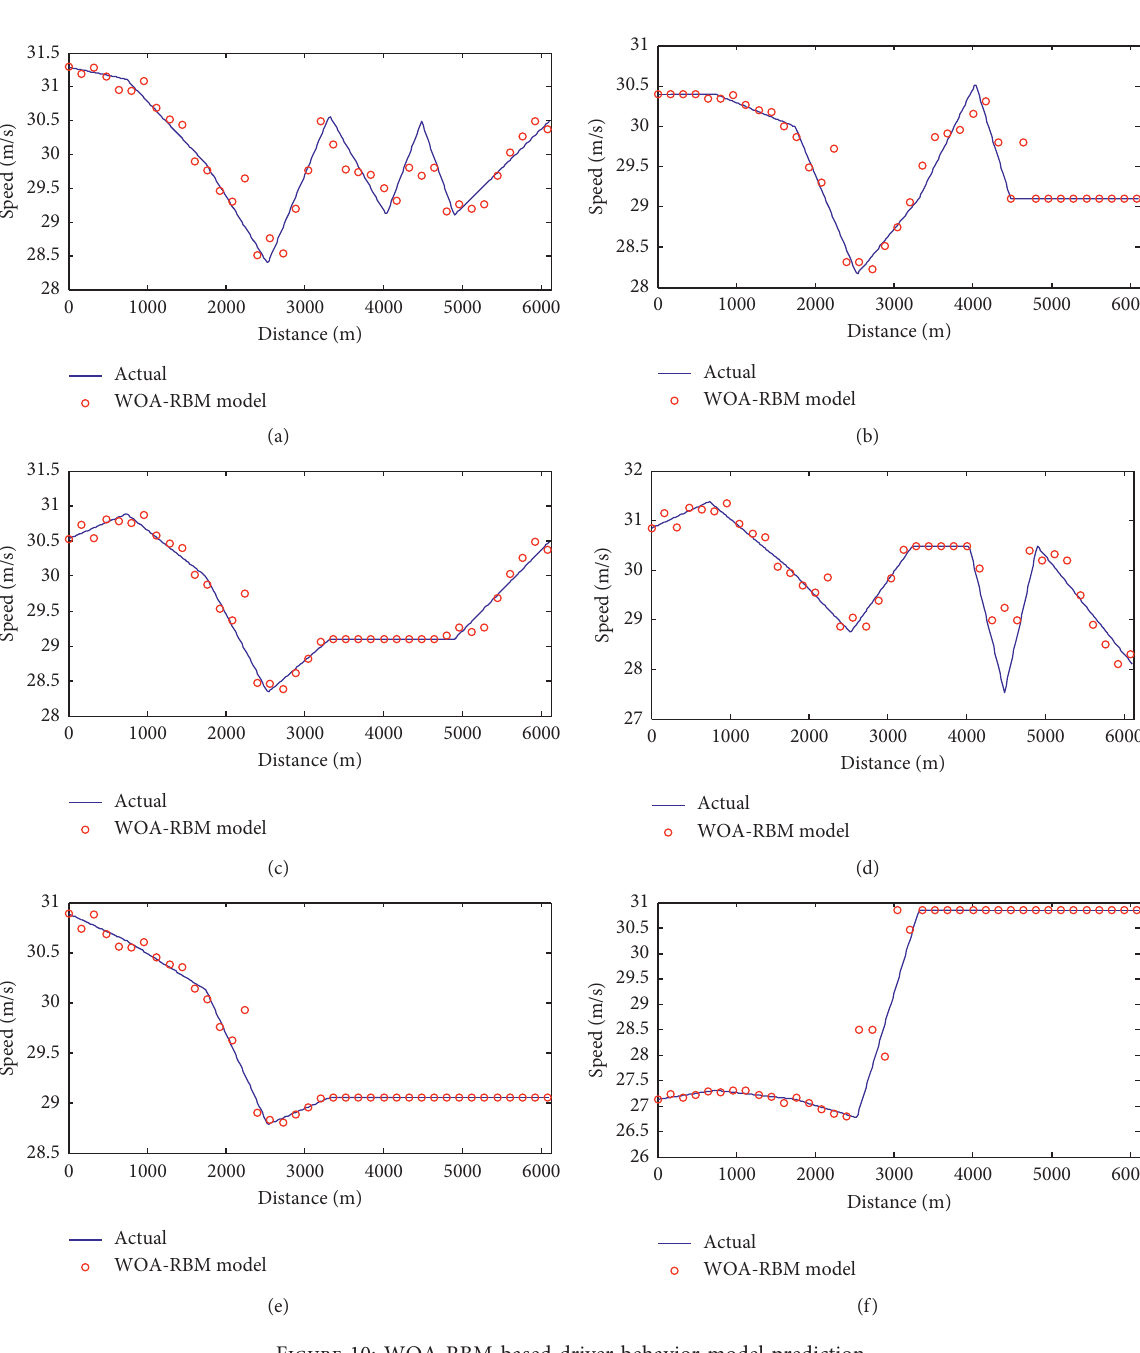
Figure 10: WOA-RBM-based driver behavior model